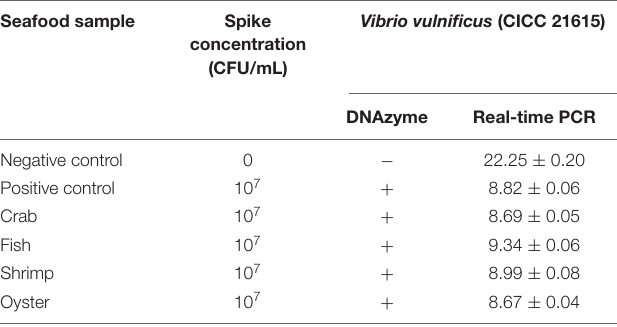
TABLE 3 | Detection of V. vulnificus in spiked seafood samples.